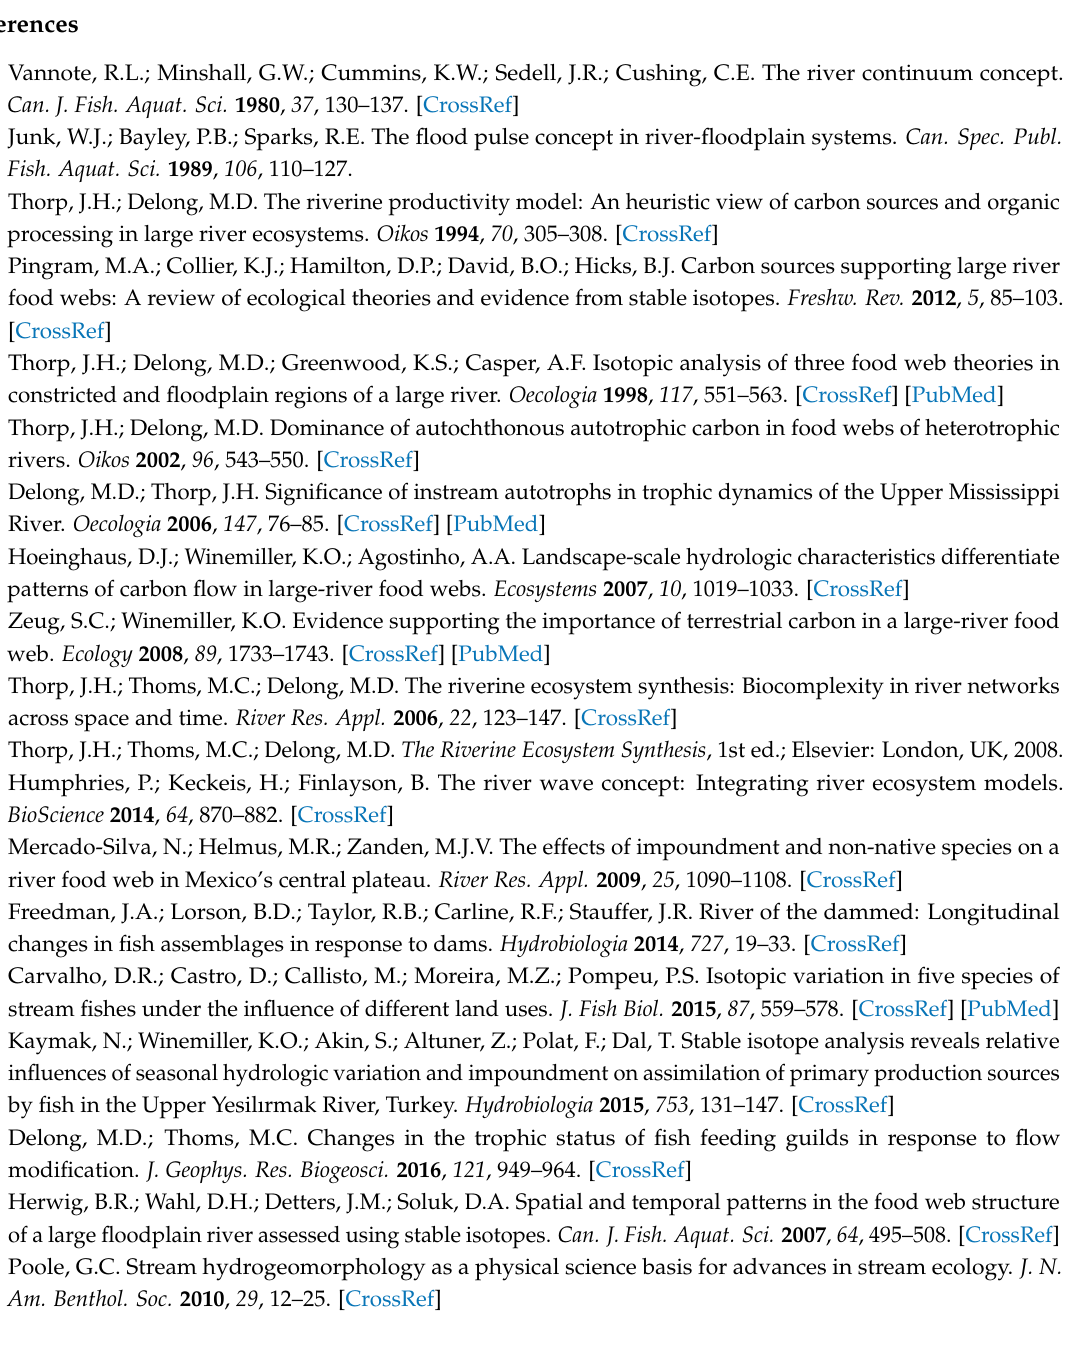
s1. Table S1. Summary of stable isotope compositions ( δ 13 C and δ 15 N, mean ± SD) for basal carbon sources and fish collected from the Daning